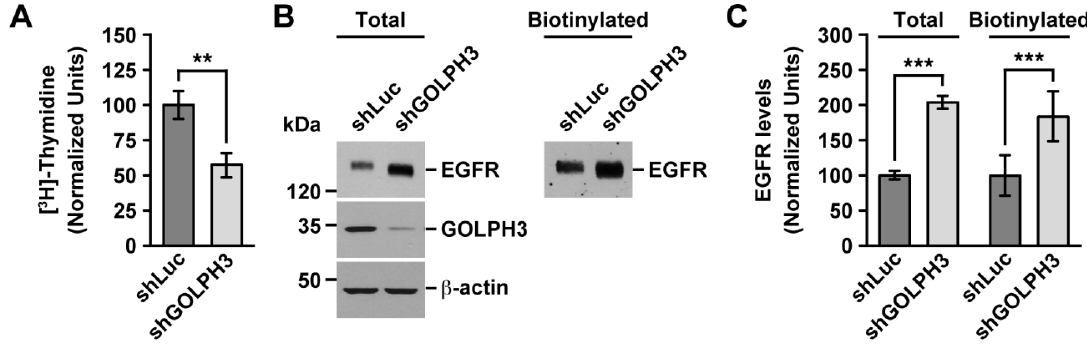
Figure 1. The knockdown of the Golgi phosphoprotein 3 (GOLPH3) a ff ects proliferation and epidermal growth factor receptor (EGFR) levels in T98G cells. ( A ) The indicated cells were serum-starved for 24 h and cultured for a further 24 h in the presence of [ 3 H]-thymidine. Cells were harvested and [ 3 H]-thymidine incorporation was quantified with a scintillation counter. Bars represent the mean ± standard deviation ( n = 5; ** p < 0.01). ( B ) Detergent-soluble extracts were prepared from the indicated cells (left panel; Total). Alternatively, the indicated cells were subjected to cell surface biotinylation and after preparation of detergent-soluble extracts, biotinylated proteins were pulled down with Neutravidin-Agarose (right panel; Biotinylated). Samples from total extracts or biotinylated proteins were analyzed by SDS-PAGE followed by immunoblotting using antibodies to detect the proteins indicated on the right. The immunoblot signal of anti- β -actin was used as a loading control. The position of molecular mass markers is indicated on the left. ( C ) Densitometry quantification of the immunoblot signal of the total or biotinylated levels of EGFR as shown in B. Bars represent the mean ± standard deviation ( n = 5; *** p < 0.001).